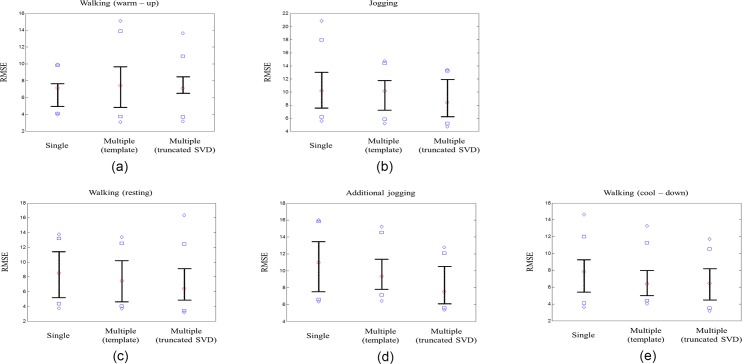
RMSEs distribution of the single-channel method, multiple channel-based template update method, and the proposed method with our DCRW.(a) walking (warm-up), (b) jogging (main exercise), (c) walking (rest), (d) additional jogging (main exercise) and (e) walking (cool-down). The diamonds above and below represent the 5th and 95th percentiles of each group, and the squares above and below represent the 90th and 10th percentiles. Whiskers above and below indicate the 75th and 25th percentiles, respectively. The circle is the median value.